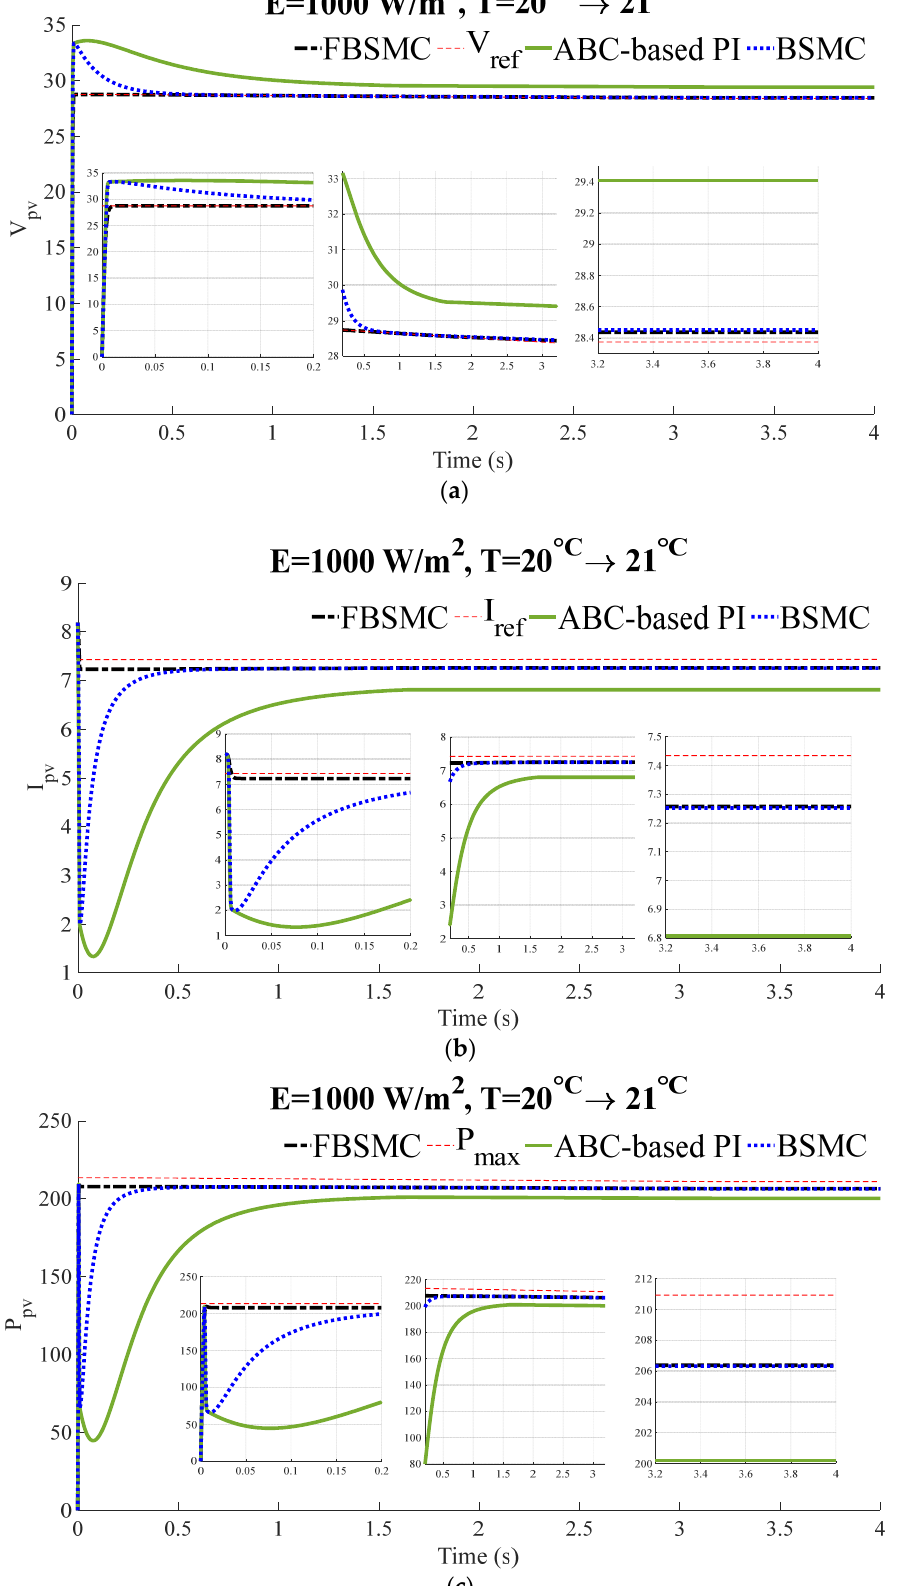
Figure 6. ( a ) Voltage ( b ) current, ( c ) power of the controlled PV (Scenario 3).